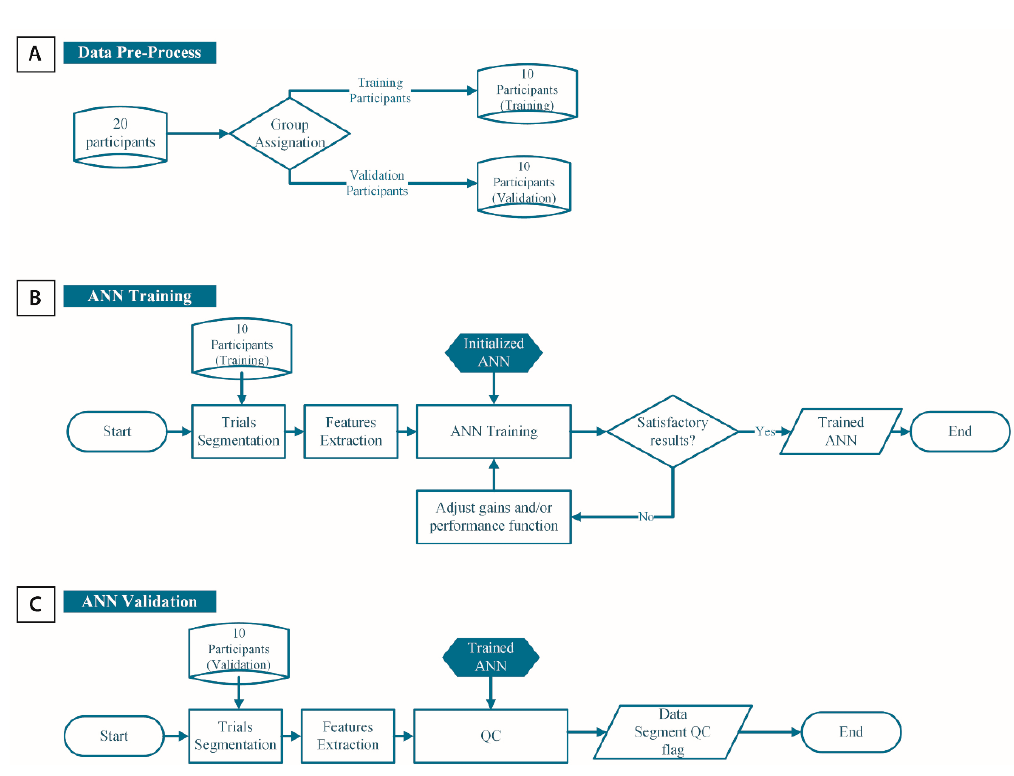
Figure 4. Data processing overall workflow using an ANN for joint orientation estimates